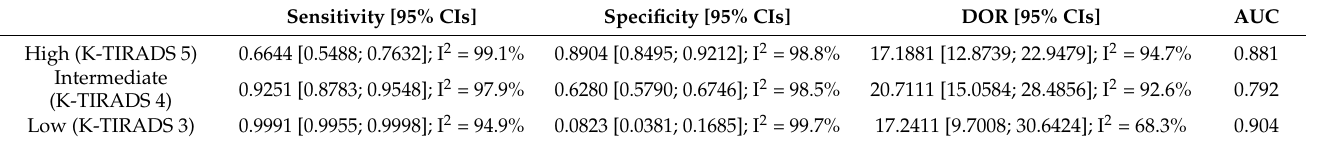
Table 1. Diagnostic efficacy and the ROC curves of K-TIRADS categories .